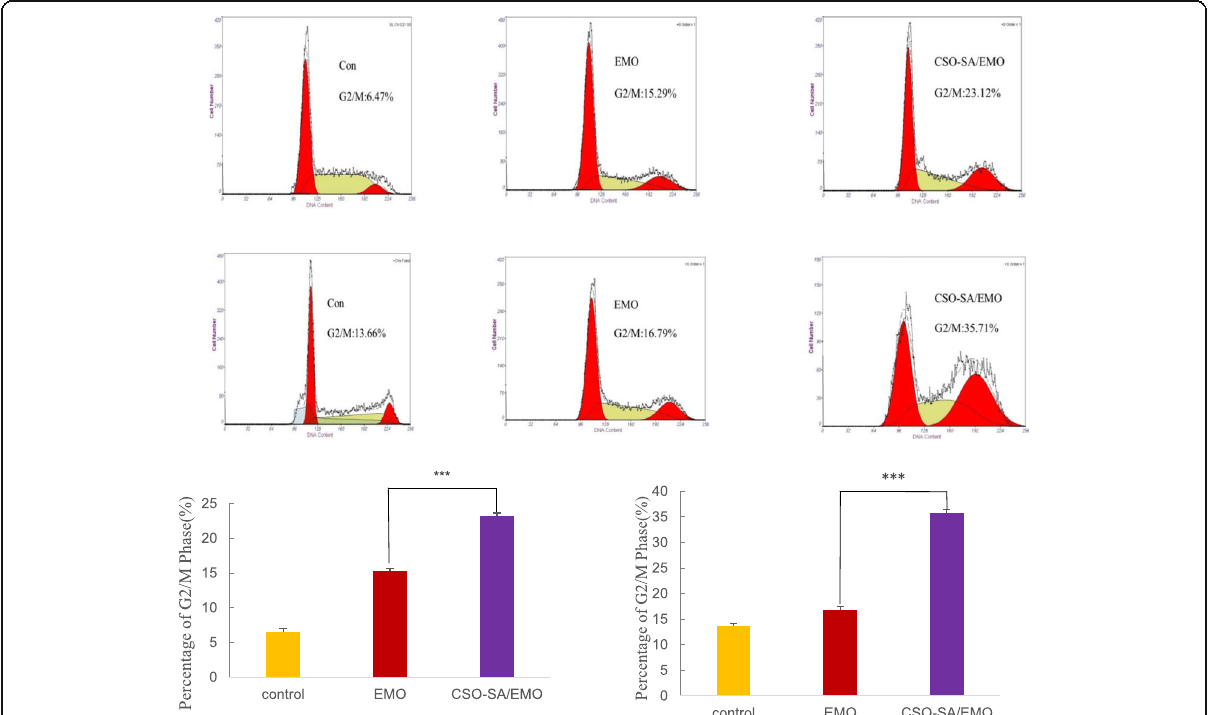
Fig. 8 Cell cycle distributions of MGC803 and BGC823 cells treated with EMO and CSO-SA/EMO for 24 h. Student ’ s t test was calculated and the data are presented as the means ± SD ( n = 3), (* p < 0.05, ** p < 0.005, *** p <